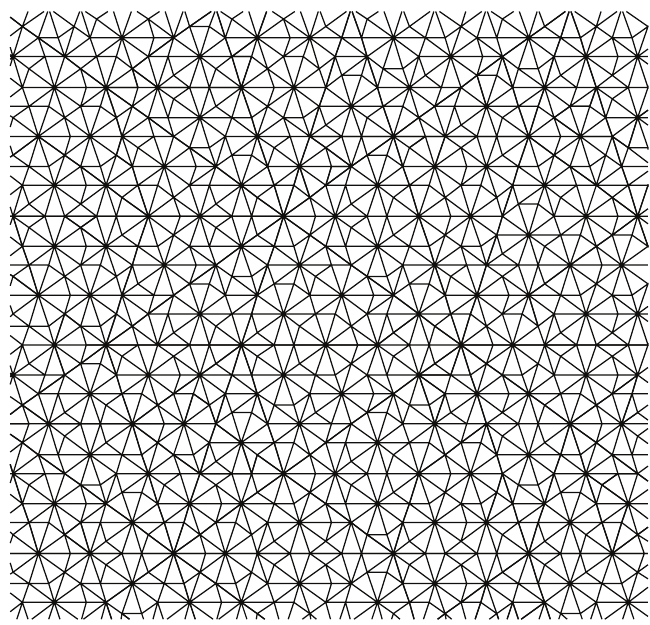
Figure 5: A fragment of (cid:6)Φ (cid:8) Φ − (cid:7) 5 .